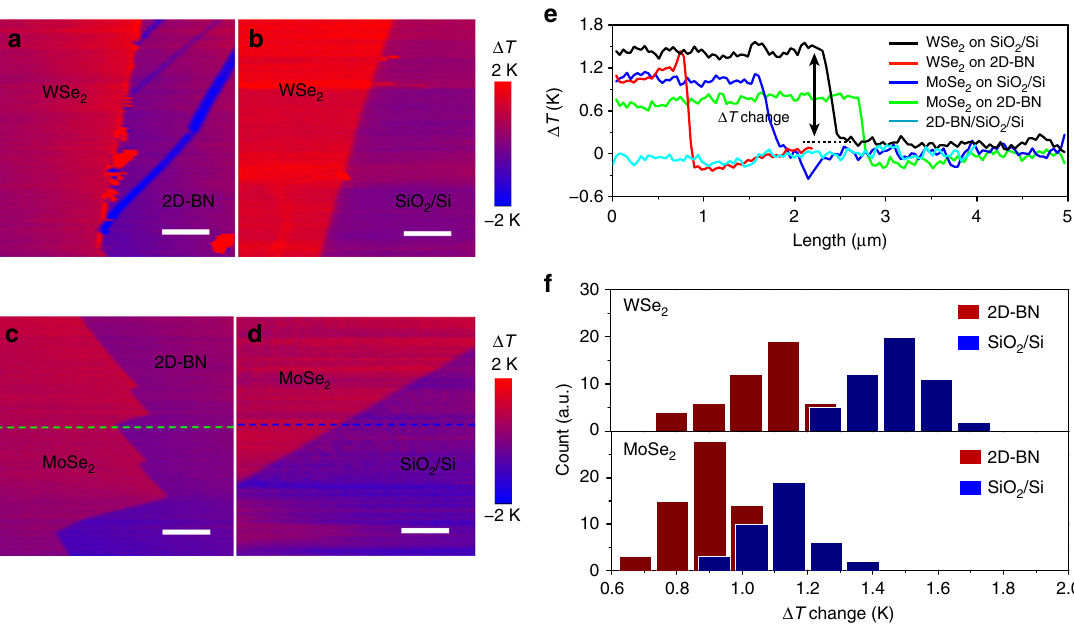
Fig. 6 Scanning thermal microscope (SThM) measurement of the interfacial thermal dissipation. a – d SThM thermal images of a WSe 2 on 2D-BN/SiO 2 /Si, b WSe 2 on SiO 2 /Si, c MoSe 2 on 2D-BN/SiO 2 /Si, and d MoSe 2 on SiO 2 /Si. e The cross-sectional pro fi les where temperature changes ( Δ T ) are recorded across the 2D-BN/SiO 2 /Si surface or the WSe 2 , MoSe 2 edges along the dashed lines in a – d . f The histograms show the Δ T change across the WSe 2 or MoSe 2 edge on 2D-BN/SiO 2 /Si or SiO 2 /Si. Scale bars in a – d are 1 μ